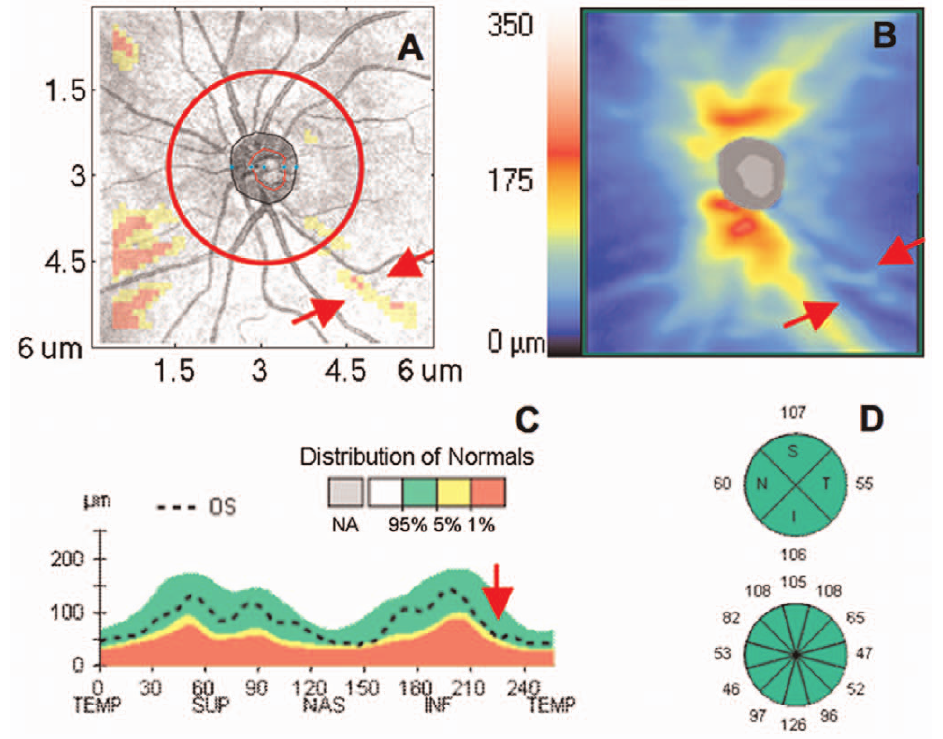
Figure 1. An example of conventional circumpapillary retinal nerve fiber layer (cpRNFL) analysis as provided by Cirrus HD-OCT. (A) Overlay of RNFL thickness deviation map on the OCT fundus image with focal wedge defect (red arrows) predominantly outside the 3.4 mm diameter circle sampling (red circle). (B) Corresponding 2D RNFL thickness map, RNFL focal defect is marked with red arrows. (C) cpRNFL thickness profile along the 3.4 mm diameter circle is within the normal range (green range). Red arrow pointing to the approximate location of the RNFL wedge defect. (D) The RNFL thickness measurement is summarized in 4 quadrants and 12 clock hours with all sectoral measurements within the normal range.